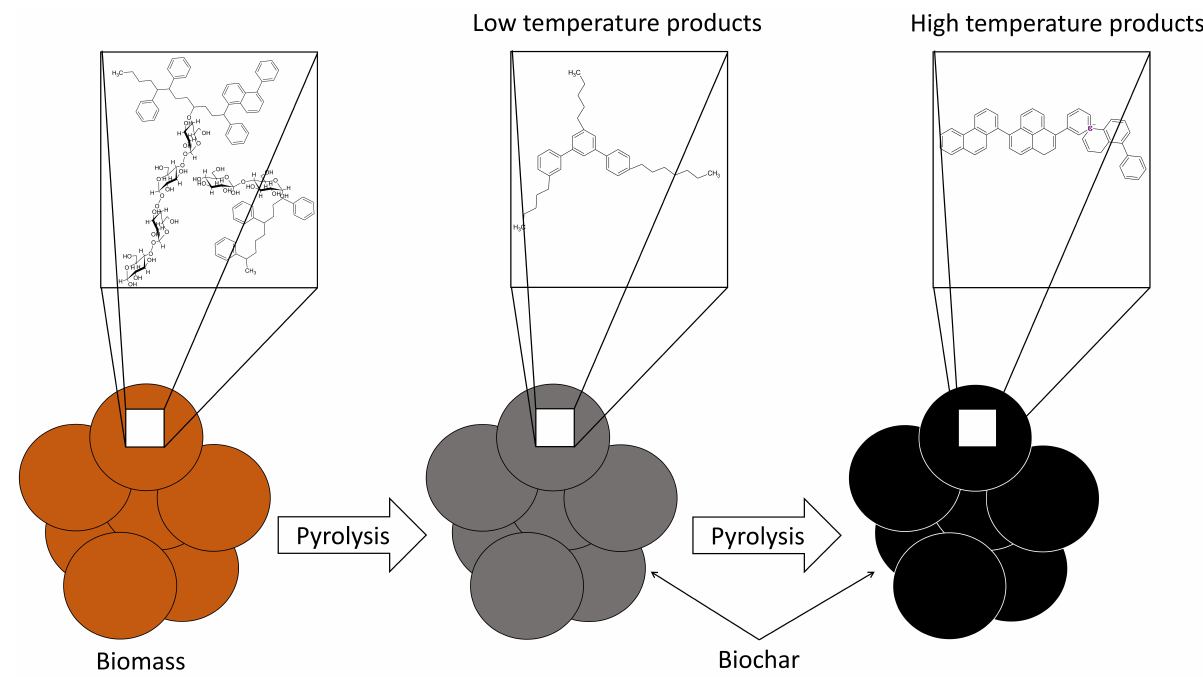
Figure 6. Schematic representation of the chemical transformations occurring in biomasses as pyrolysis temperature